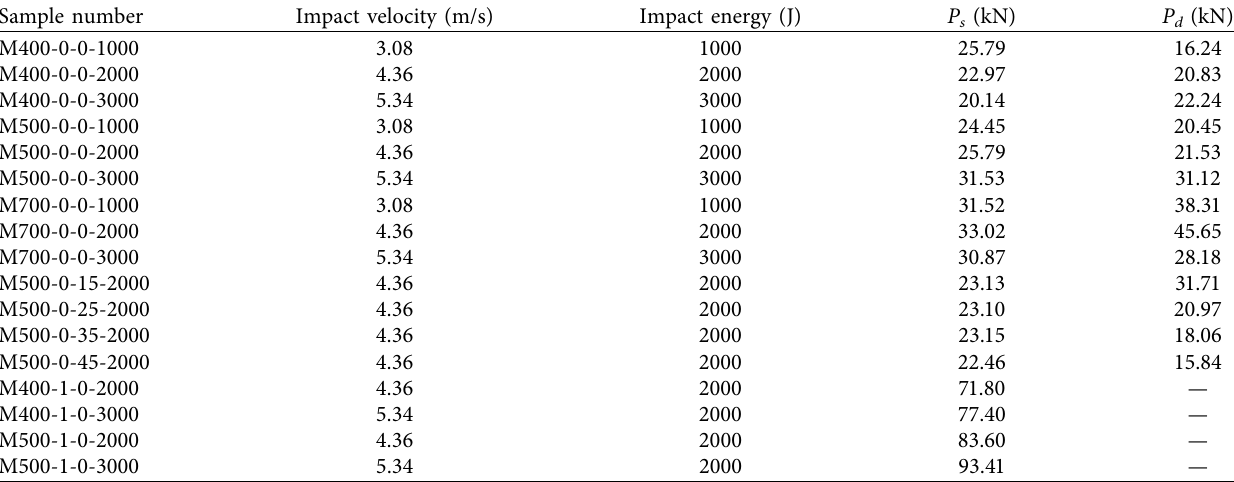
Table 2: Experiment scheme and